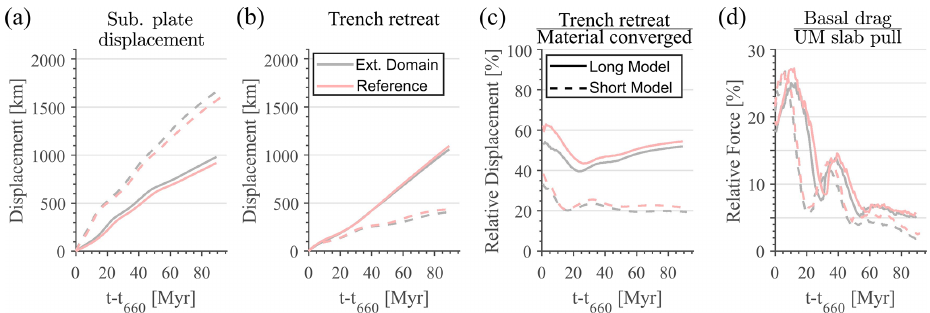
Figure 7. Temporal evolution of the long-plate (full lines) and short-plate (dashed lines) extended domain (grey) and reference (light red) models. (a) Displacement of the subducting plate from the initial state. (b) Amount of trench retreat. (c) Trench retreat significance as percentage of the total material converged. (d) Ratio of basal drag to upper-mantle slab pull